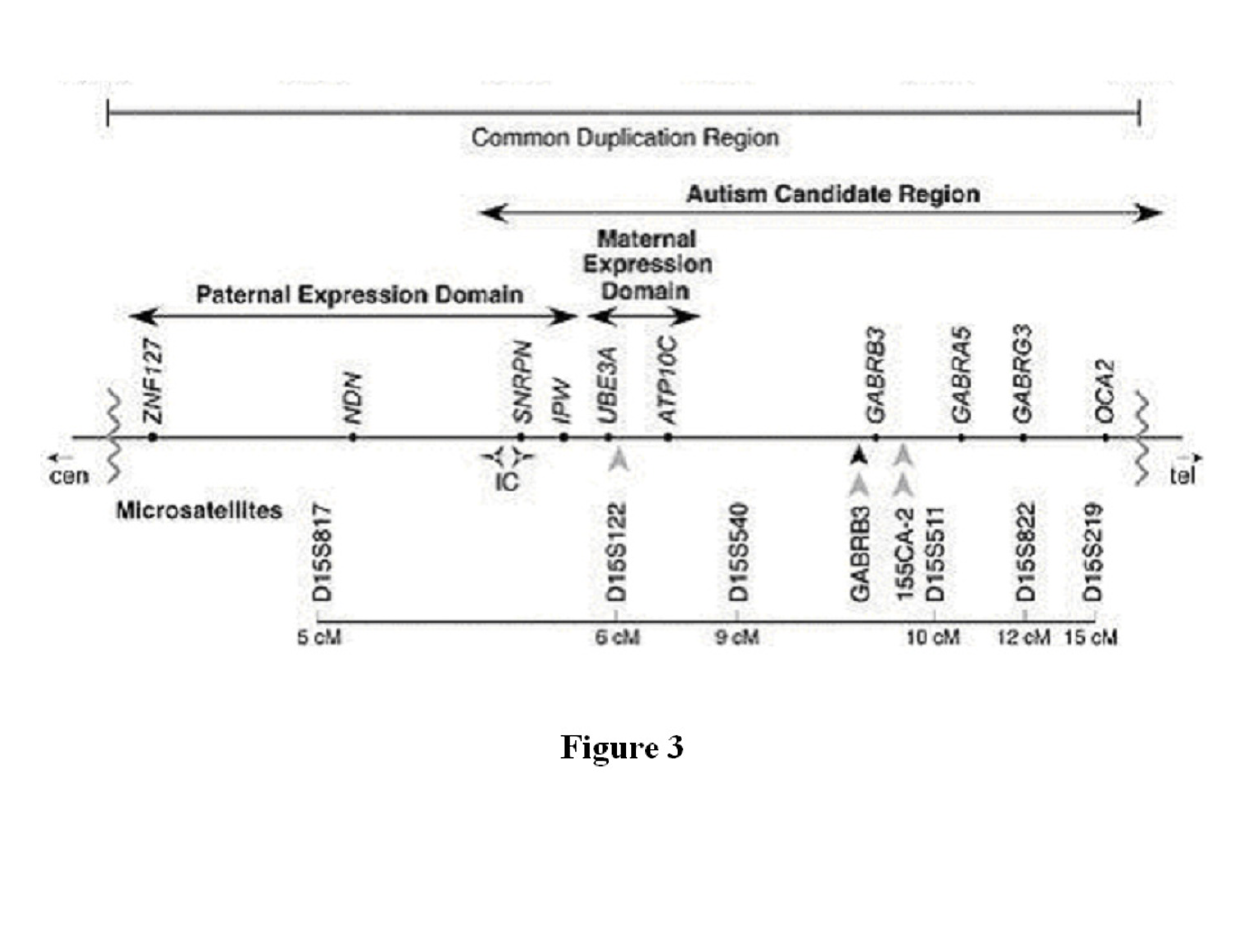
Figure 3 Chromosome 15q11-q13 region showing the autism candidate region. A schematic representation of the 15q11-q13 interval duplicated in autism cases and deleted in Prader-Willi/Angelman syndrome is shown. IC denotes the position of the 15q imprinting center. Loci corresponding to previous reports of linkage and association are indicated by dark and light arrow- heads, respectively, below the map. (Adapted with permission from Sutcliffe J et al article "Dense linkage disequilibrium map- ping in the 15q11-q13 maternal expression domain yields evidence for association in autism' in Molecular Psychiatry (2003)